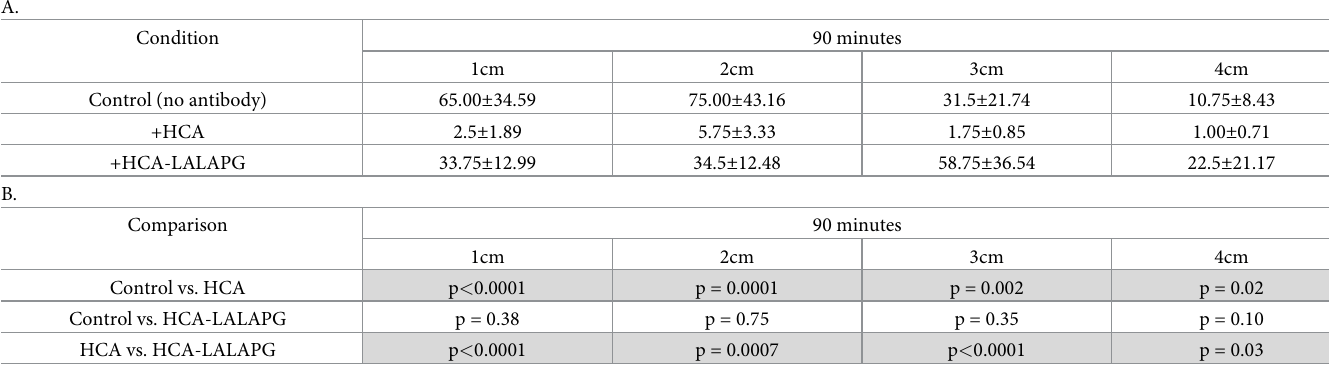
Table 1. Cervical mucus penetration at 90 minutes with HCA and HCA-LALAPG.